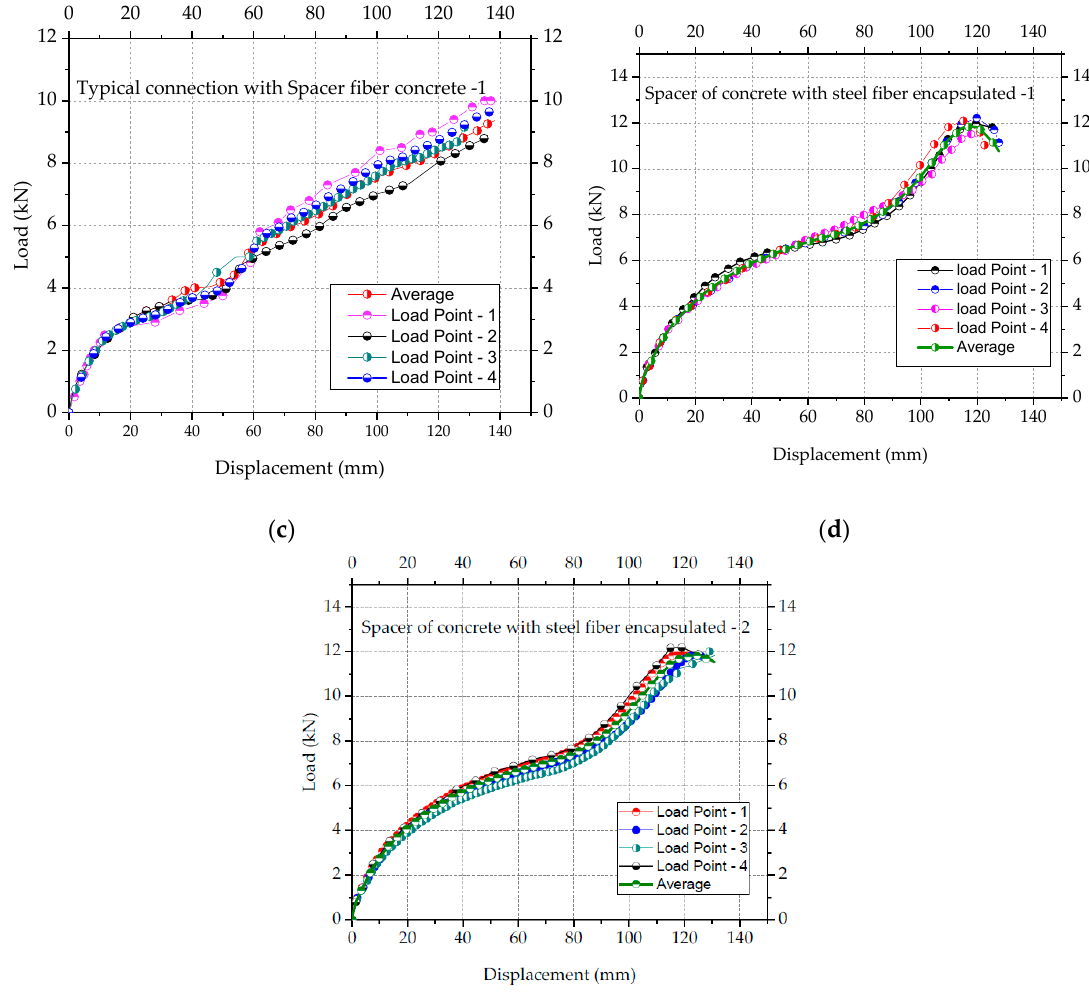
Figure 18. Result of the experimental tests. ( a , b ) Space truss without spacer, ( c ) typical connection with spacer of concrete with steel fiber, ( d , e ) space truss with spacer of concrete with steel fiber encapsulated with cold-formed steel.